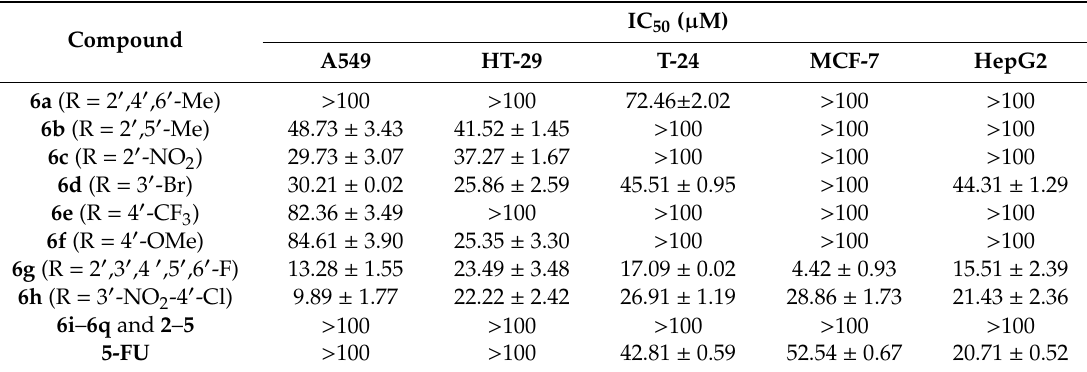
Table 2. Antiproliferative activity of the compounds 2, 3, 4, 5, and 6a – 6q a.